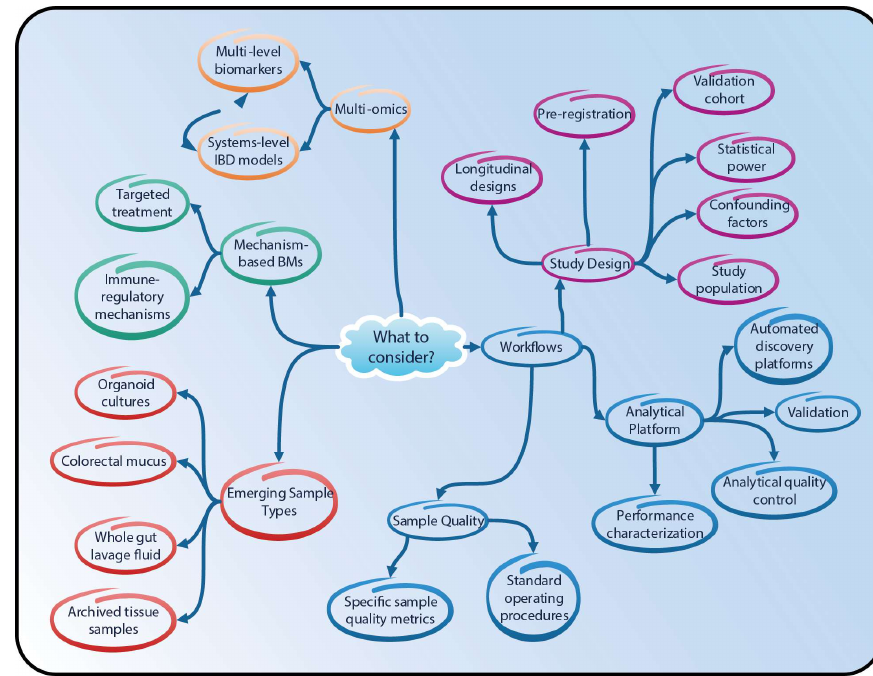
Figure 4. Aspects to consider in the design and conduct of IBD biomarker studies.